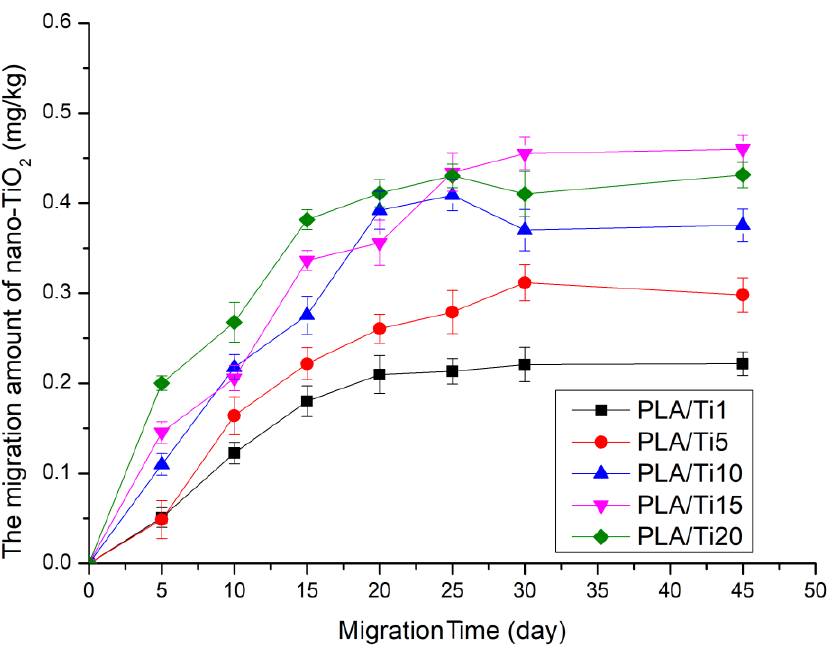
Figure 1. The amount of nano-TiO 2 migrated to food simulated solution after high pressure treatment.